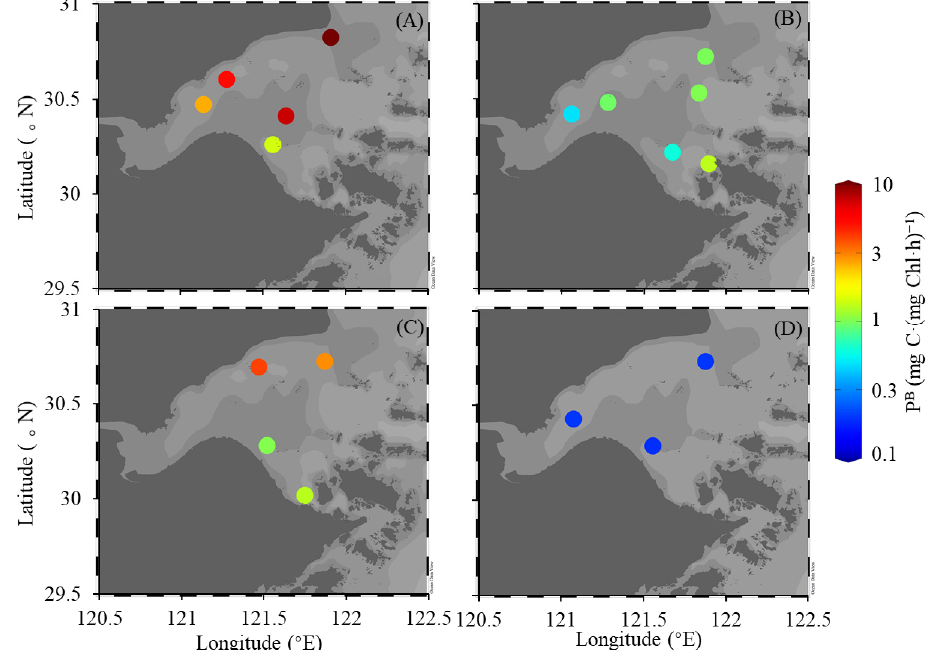
Figure 6. Spatial and temporal variations P B (mg C · (mg Chl · h) − 1 ) in ( A ) July 2006, ( B ) December 2006, ( C ) April 2007 and ( D ) October 2007.